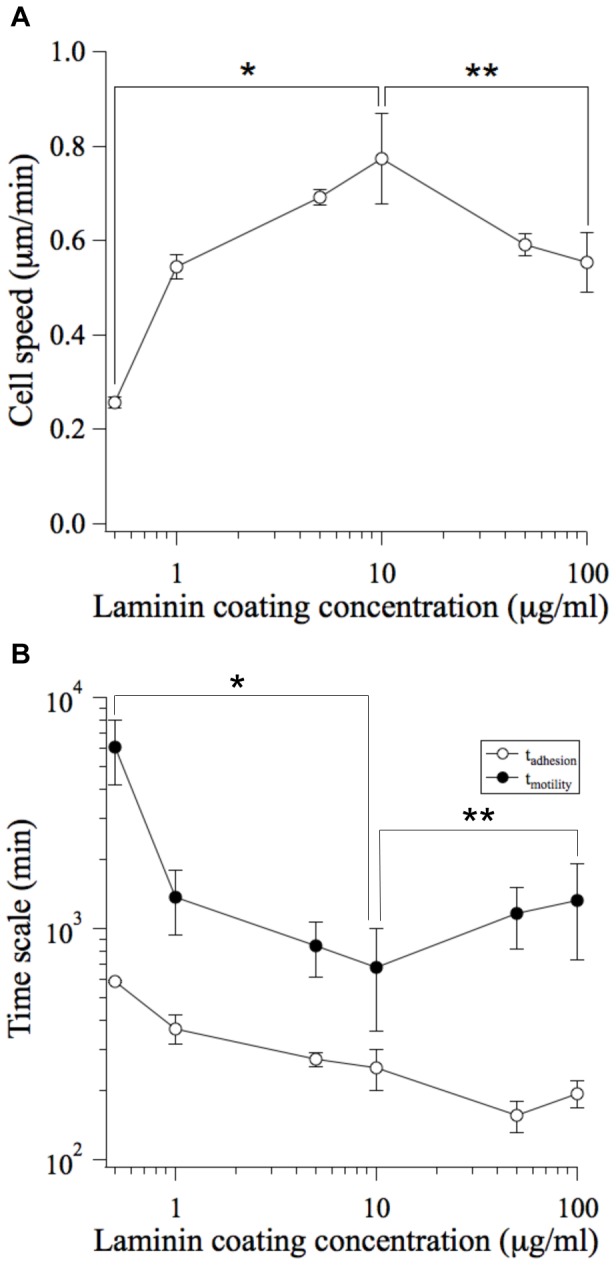
Quantitative comparison of the timescales of cell-cell reactivity (tadhesion) and transport (tmotility).(A) The migration tracks of individual MDCK cells were traced using timelapse microscopy. Mean squared displacements were calculated and fit to a persistent random walk model to determine cell speed [13], [14]. Error bars, s.e.m. (n = 2–3 trials; N>20 cells per trial). *P<0.05 between 0.5 µg/mL Ln and 10 µg/mL Ln conditions. **P<0.1 between 100 µg/mL Ln and 10 µg/mL Ln conditions. (B) The mean time for nearest neighbors to collide (tmotility) was quantified for substrata prepared with different coating concentrations of Ln. tadhesion is re-plotted here for the purpose of comparison (see Figure 2B). tadhesion: error bars, s.e.m. (n = 2–3 trials; N>50 cells per trial). tmotility: error bars, s.e.m. (n = 2–3 trials; N>20 cells per trial). *P<0.05 between 0.5 µg/mL Ln and 10 µg/mL Ln conditions. **P<0.1 between 100 µg/mL Ln and 10 µg/mL Ln conditions.